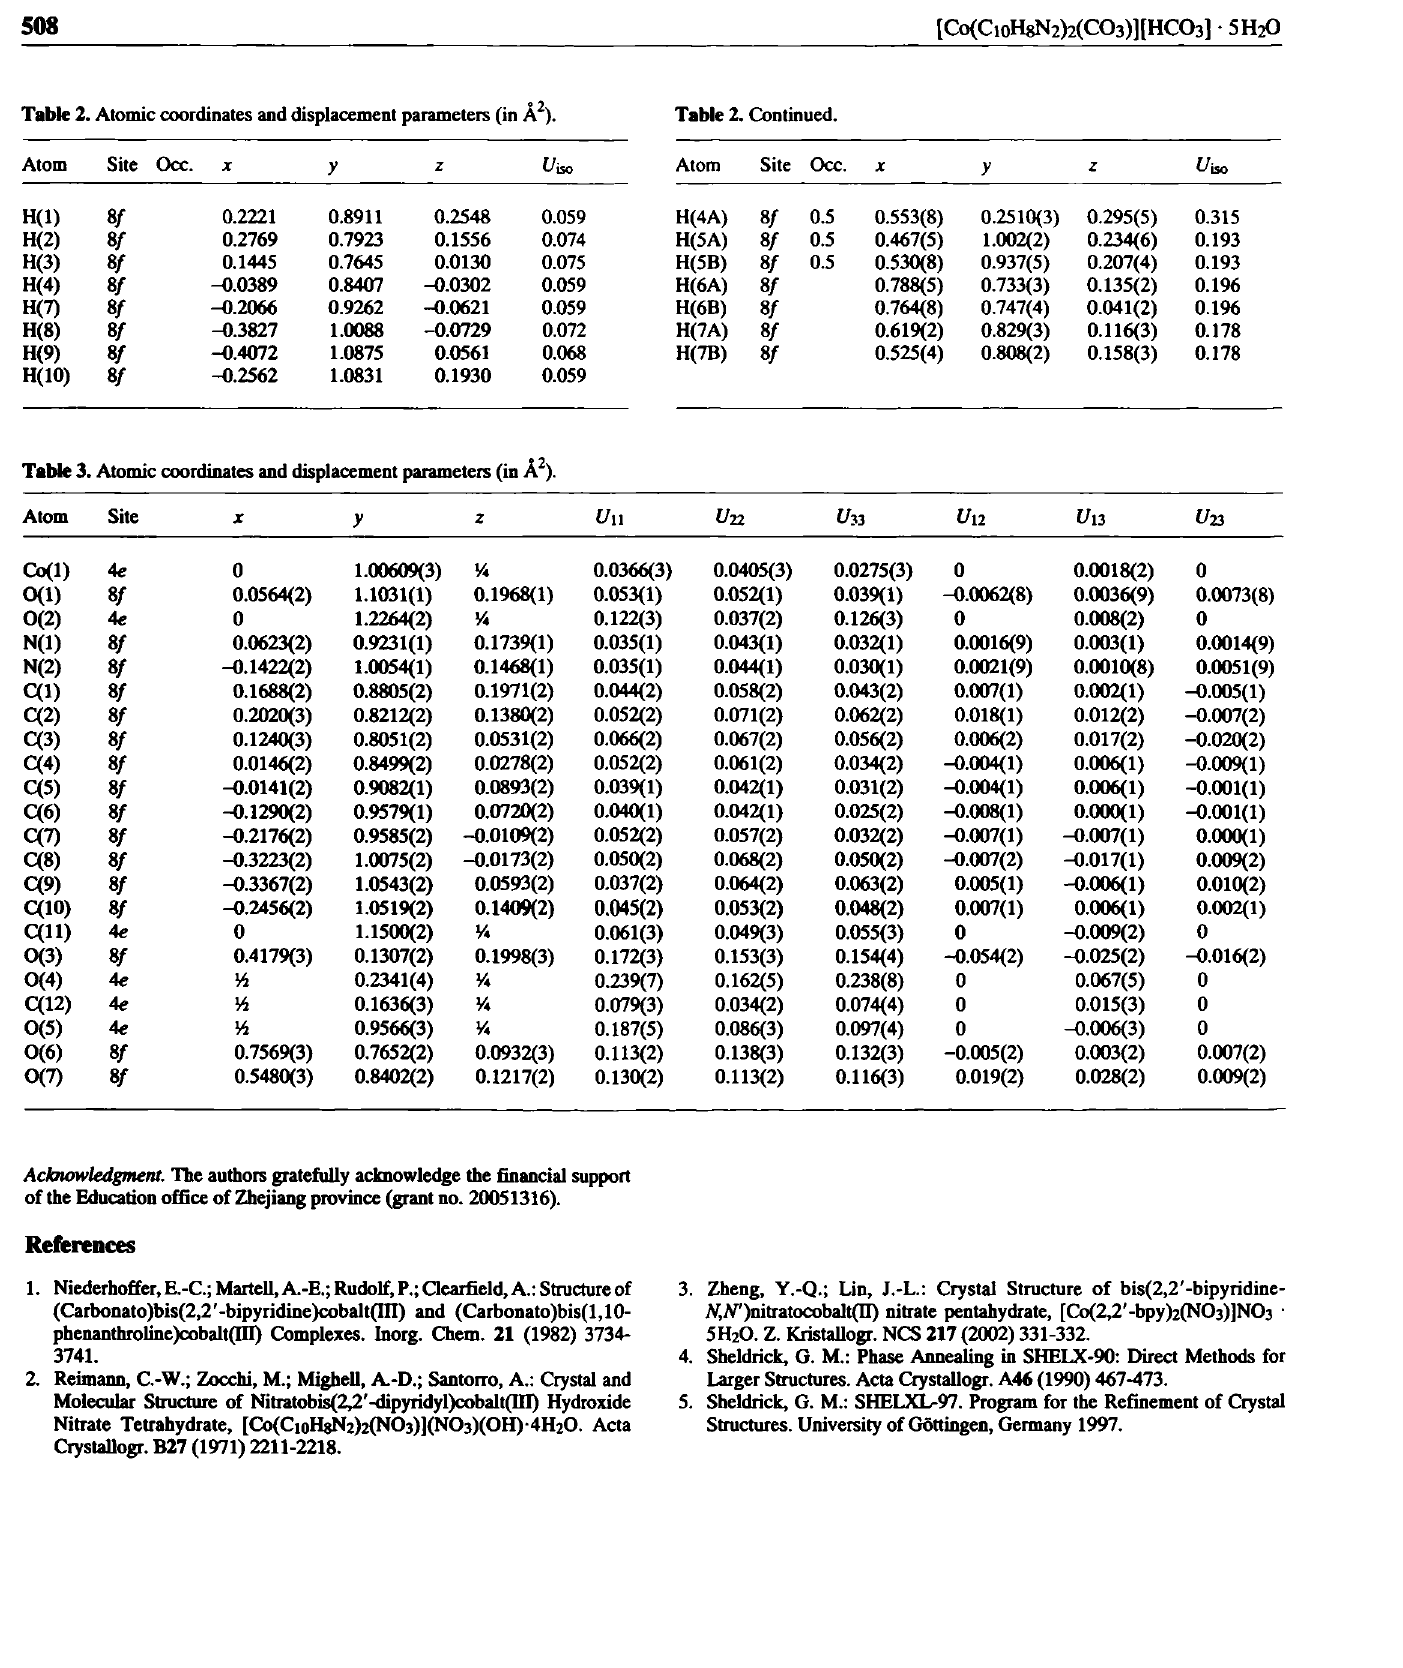
Table 2. Atomic coordinates and displacement parameters (in Ä 2 ).